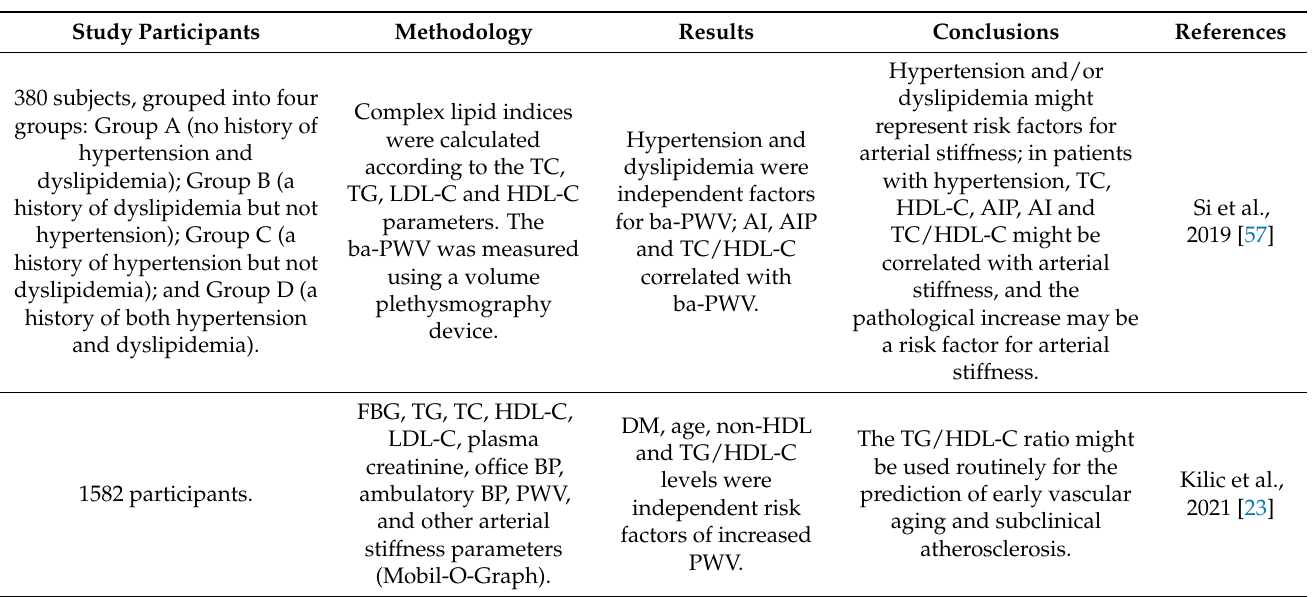
Table 2. Most relevant studies with lipid ratios and arterial stiffness (ABI = ankle-brachial index, AI = atherogenic indices, AIP = atherogenic index of plasma, BP = blood pressure, DM = diabetes mellitus, TG = triglycerides, LDL-C = low-density lipoprotein cholesterol, HDL-C = high-density lipoprotein cholesterol, non-HDL-C = non-high-density lipoprotein cholesterol, ba-PWV = brachial- ankle pulse wave